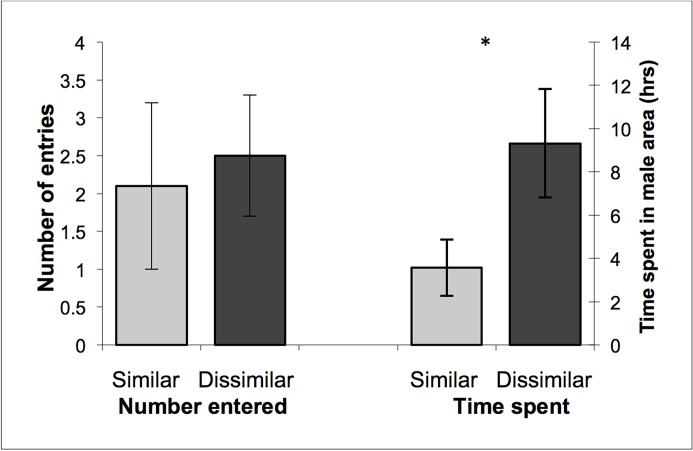
The number of entries and time spent in male enclosures.The mean (± SE) number of times female agile antechinus (n = 28) entered into the compartments of males that were more genetically similar and more dissimilar to themselves (left) and the mean (± SE) time (hours) female agile antechinus (n = 21) spent in the compartments of males that were more genetically similar and more dissimilar to themselves (right). An asterisk (*) indicates a significant difference from the other value (p = 0.046).